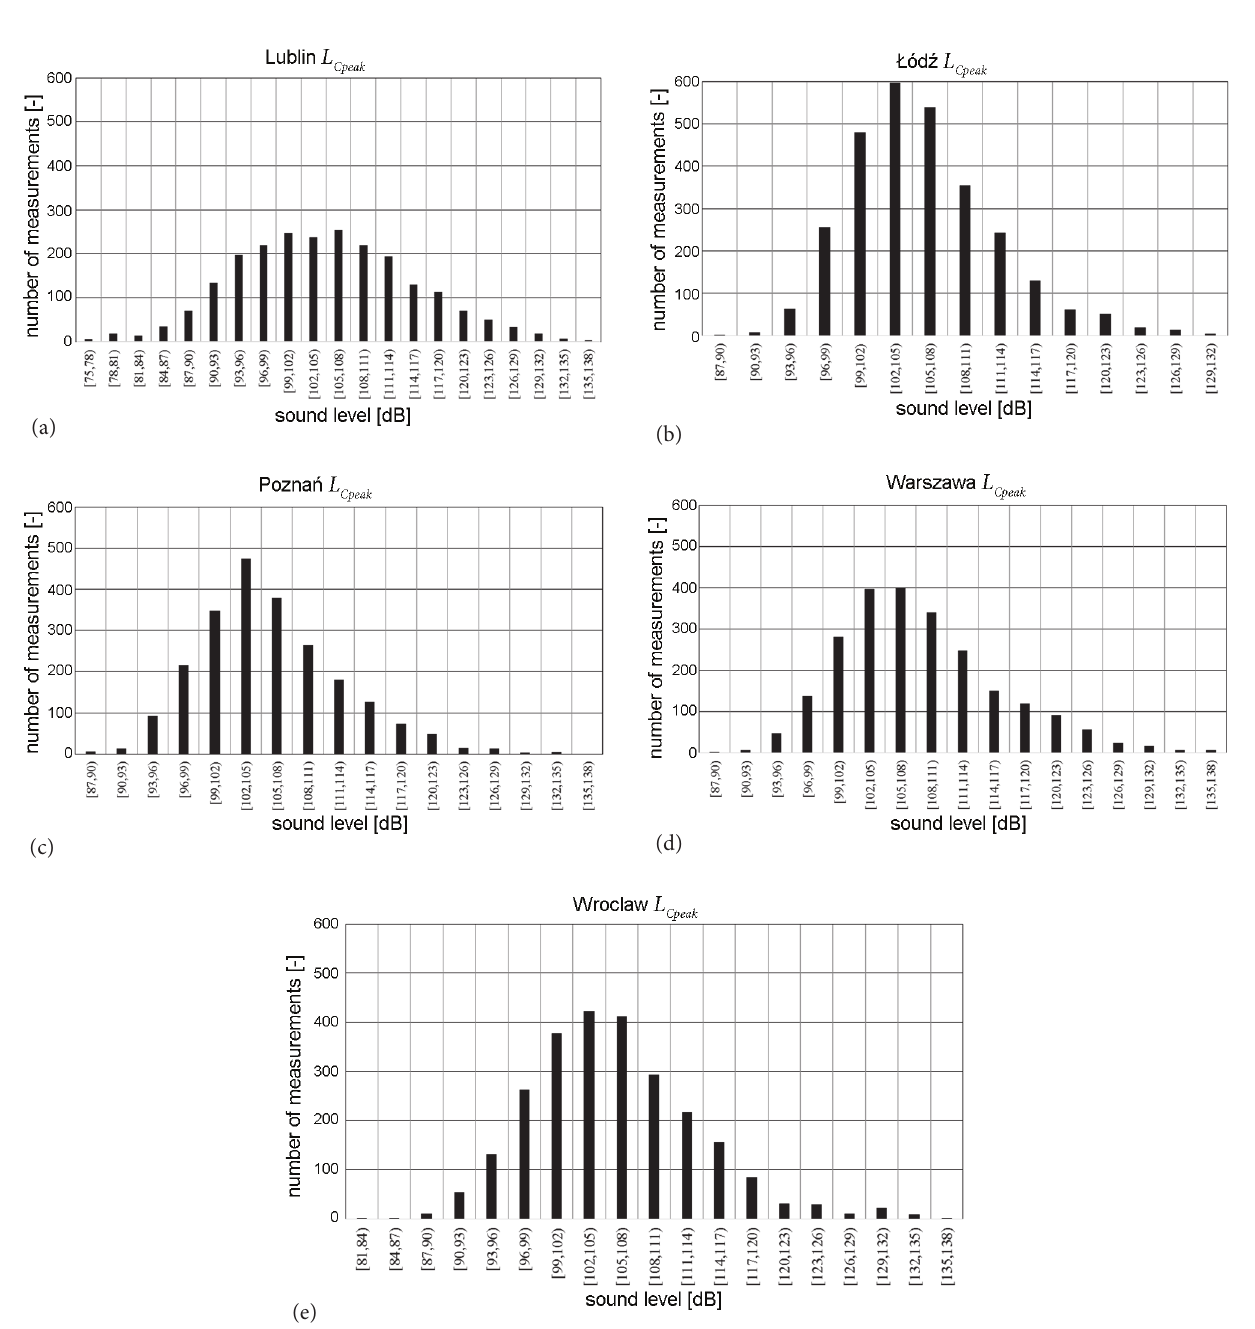
Figure 4. C-Weighted peak sound level registered on scaffolds: (a) – in